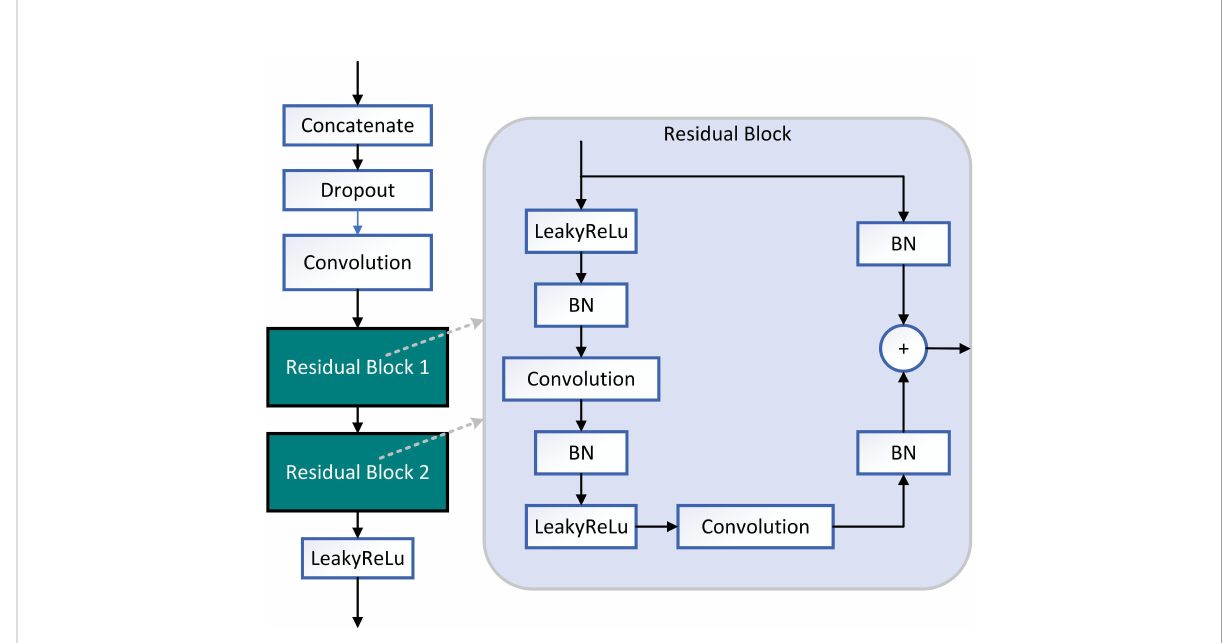
FIGURE 6 Structure diagram of decoding subblock. Two residual blocks are used in decoding block. The activate function of decoding subblock is LeakyReLU.